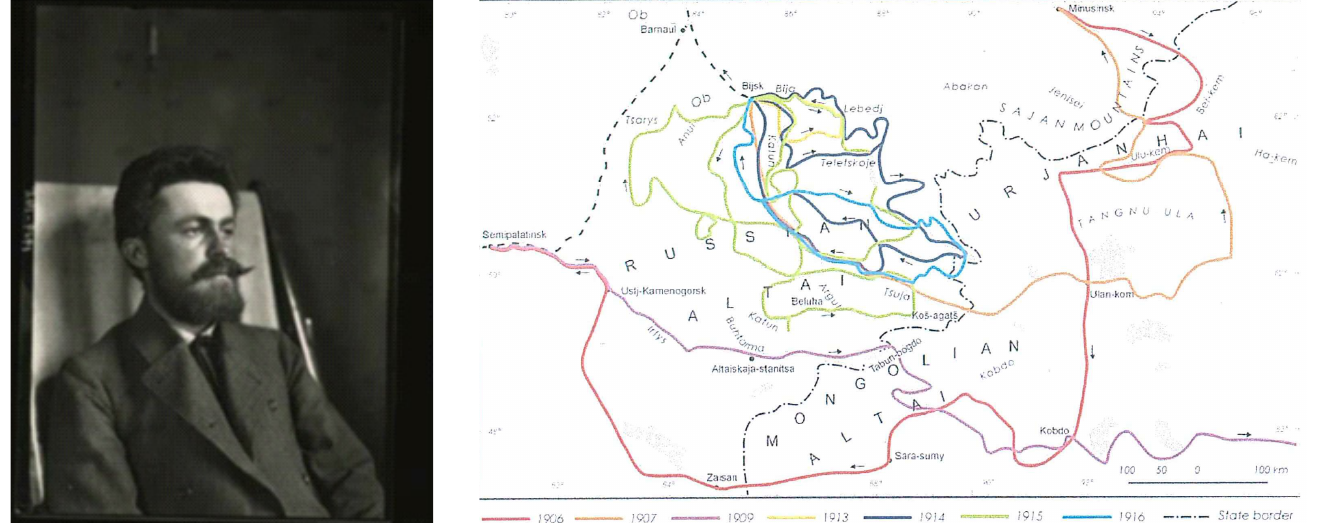
Figure 1: Left: J.G. Granö at the age of 27 (1909), and right: his Altai routes 1906 – 1916 (Buttimer,